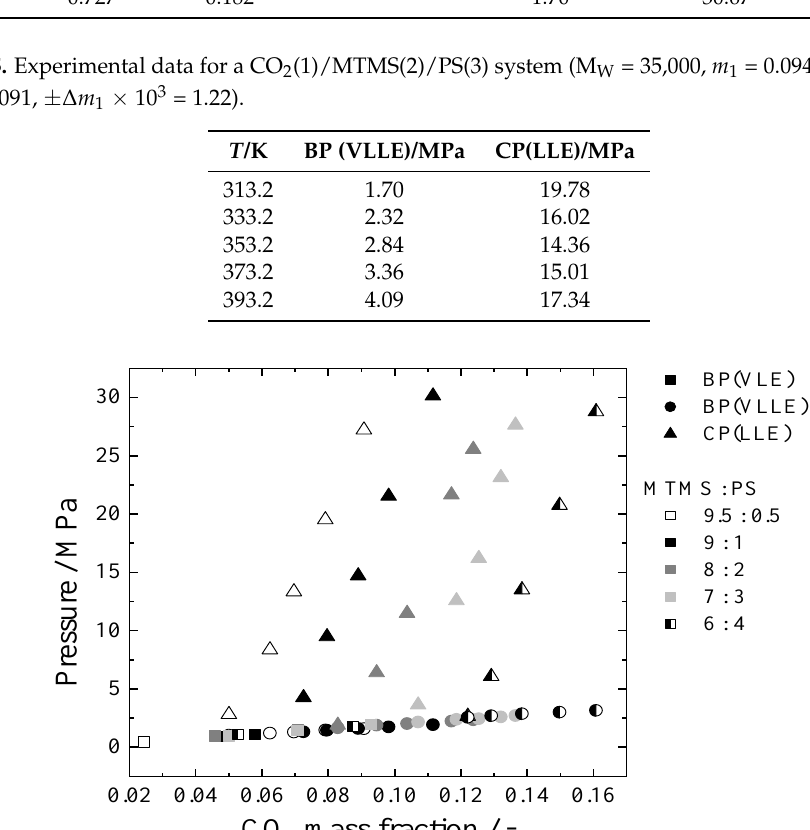
Figure 1. Phase behavior of a CO 2 /MTMS/PS ternary system (M W = 35,000, 313.2 K).